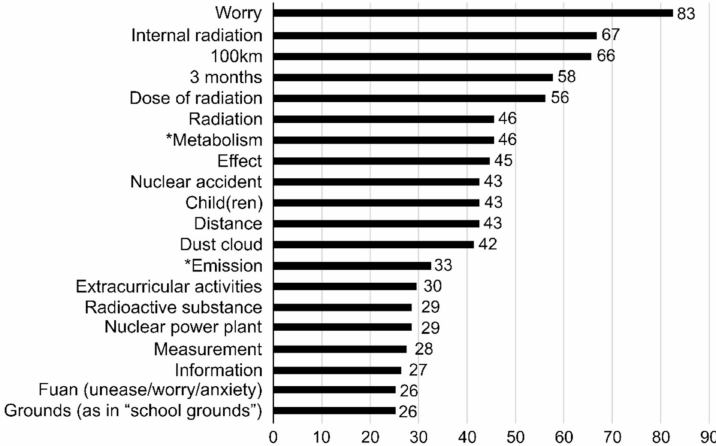
Figure 3. The nouns that students wrote on the post-class worksheet with regard to how they would respond to the example scenario and the number of students who wrote them. Note: words that did not appear in worksheet #1 are marked with an asterisk